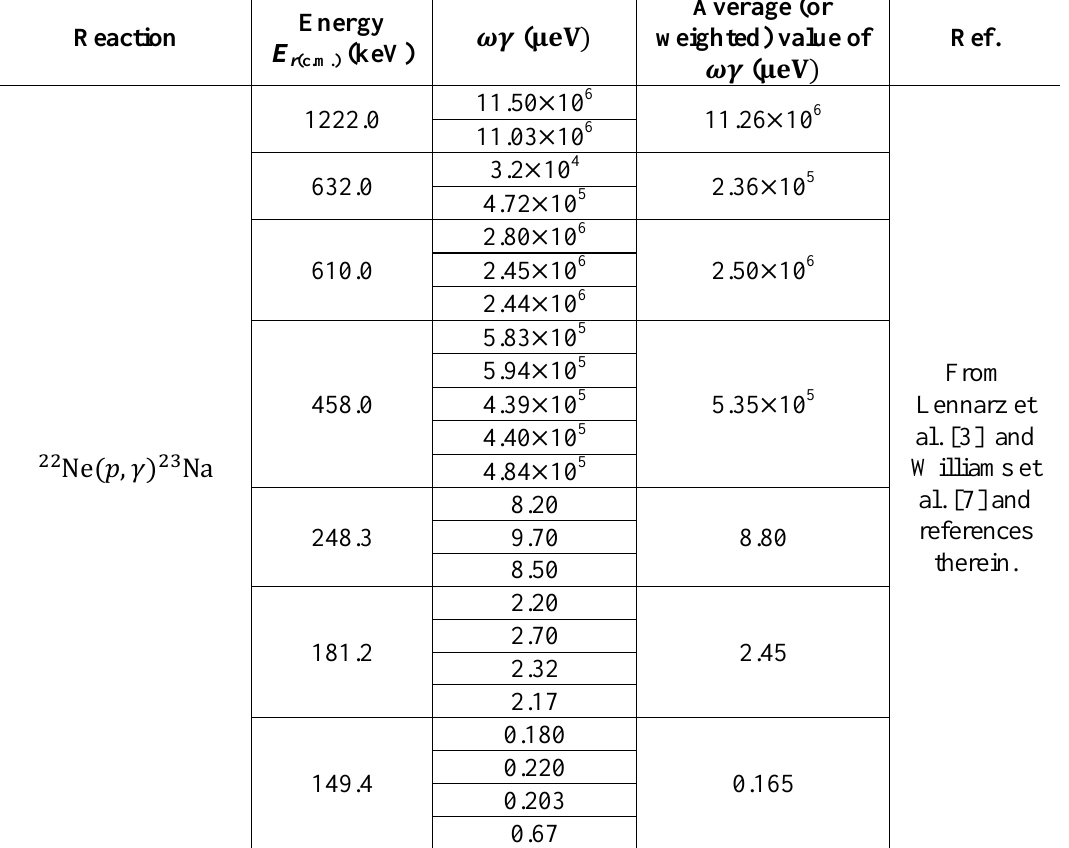
Table 1: The nuclear resonance strengths at thermonuclear energies for reaction. Highlighted values are the most recent kinematics. Reaction